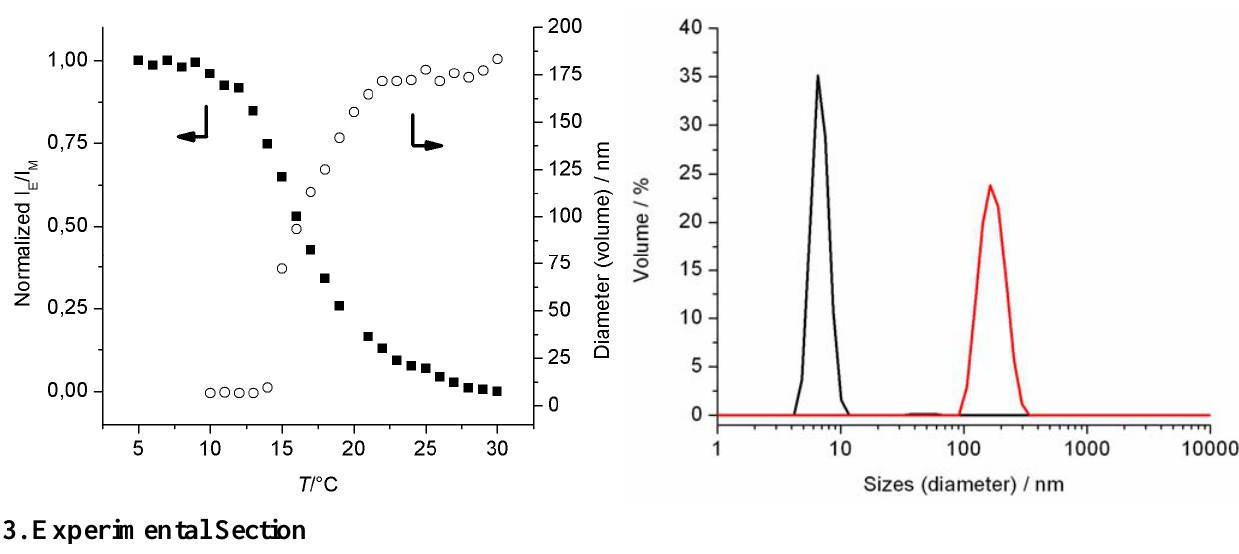
Figure 4. ( a ) The ratio of excimer (467 nm) to monomer (395 nm) emission intensities /I , black squares) and the hydrodynamic radius of the polymer globules (DLS, open (I E M circles) of copolymer 5 at 1.0 mg mL − 1 as function of temperature. ( b ) The hydrodynamic radius of the polymer globules at 5 °C (black) and 30 °C (red) as determined by DLS at 1.0 mg mL − 1 (CONTIN